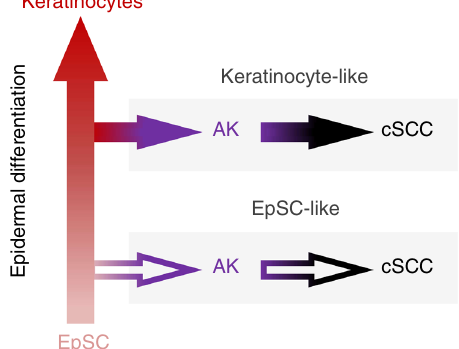
Fig. 7 Model describing the emergence of AK/cSCC subtypes from different stages of epidermal differentiation. Mutations giving rise to AK can result in the transformation of distinct epidermal differentiation stages, resulting in two distinct subclasses